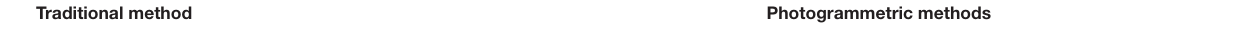
TABLE 3 | Comparison of the survey methods deployed in this study. Abbreviations: NA = not